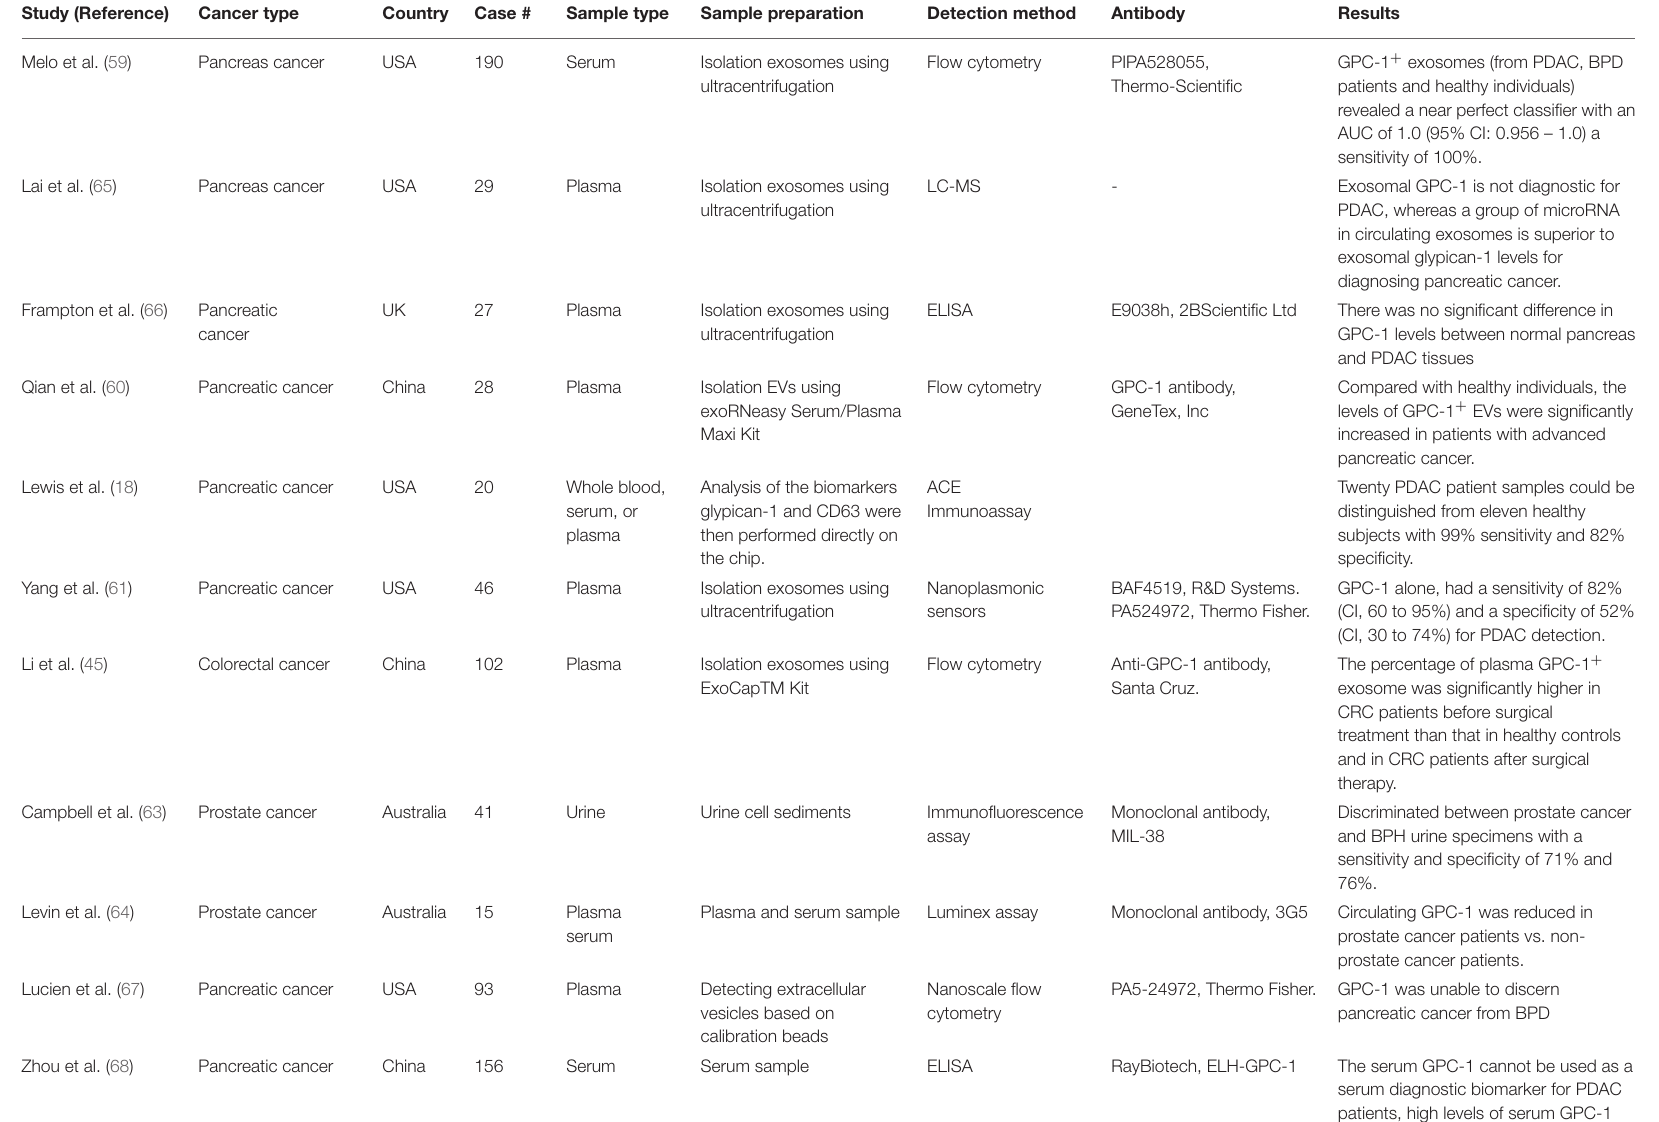
TABLE 1 | Circulating GPC-1 as a diagnostic and prognostic marker for